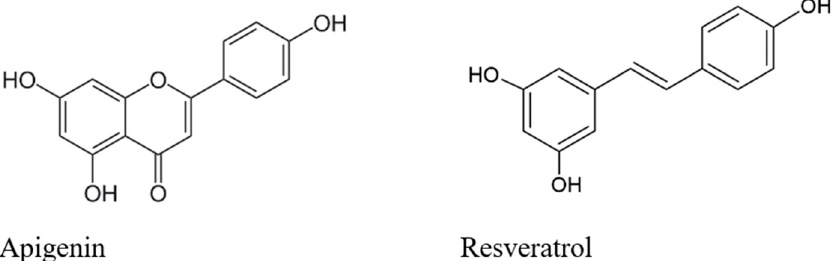
Figure 2. Selected chemical constituents of G. lucidum methanolic extract, from the group of phenolic compounds. lic